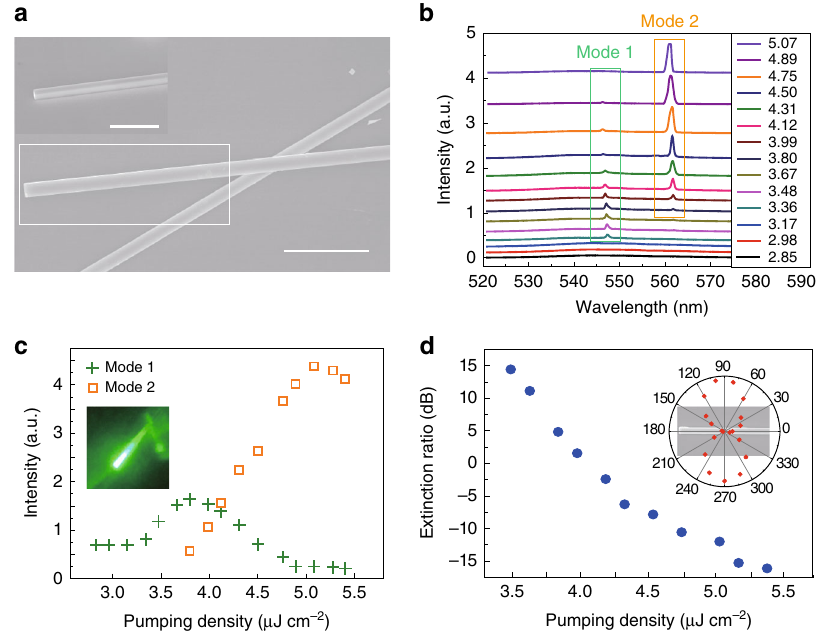
Fig. 2 The optically switchable perovskite microlasers. a The SEM image of the perovskite microrod. Inset: tilt-view SEM image. The length of two scale bar are both 10 μ m. b The emission spectra of the perovskite microrod at different pumping density ( μ J cm − 2 ). c The integrated output of mode-1 (crosses) and mode-2 (squares) as a function of pumping density. Inset: Fluorescent microscope image of the microrod. d The extinction ratio of two lasing modes. Inset: The polarization of emitted light